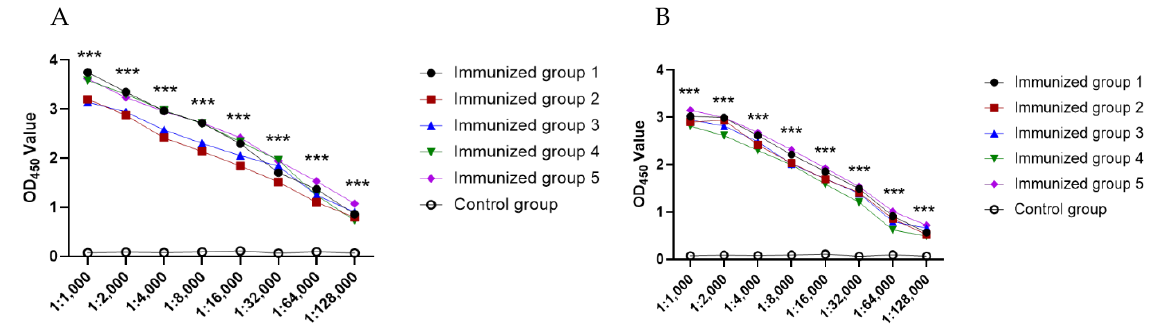
Figure 2. Five mice antibody titers against Rep after ( A ) third around and ( B ) fourth around immunizations. The data were analyzed using SPSS18.0 and visualized by Graphpad Prism software 5.0. OD 450 : optical density 450 nm. *** p < 0.001.